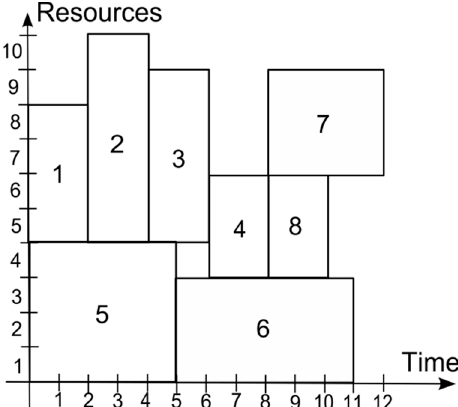
Figure 2. Baseline schedule.